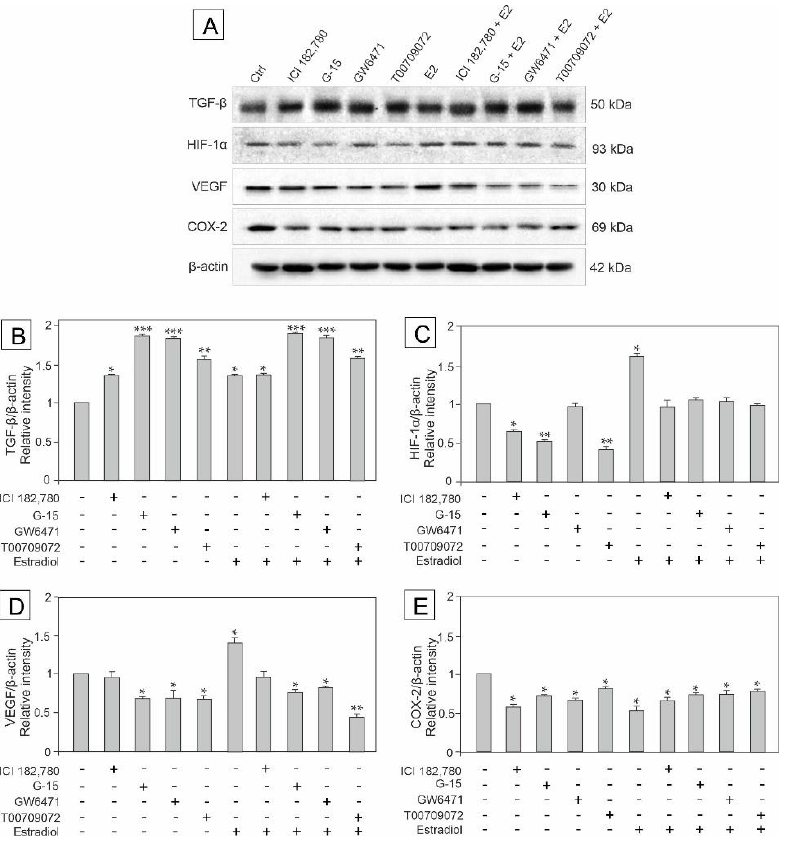
Figure 3. The effect of GPER agonist (ICI 182,780), GPER antagonist (G-15), PPAR α antagonist (GW6471), PPAR γ antagonist (T00709072), and estradiol (E2) on TGF- β , HIF-1 α , VEGF and COX-2 protein expression in mouse testis explants ( A – E ). Representative blots of Western analysis ( A ) and relative expression of the proteins ( B – E ). Explants were harvested after 24 h. Untreated explants served as a control. Untreated explants served as a control. Protein levels within control testis explants were given a value of 1. Displayed are the cropped blots and original blots are provided in Supplementary Materials Figure S1. The relative levels of the proteins were normalized to β -actin which served as the internal protein loading control. The histograms are the quantitative representation of data (mean ± SD) of three independent experiments, each in triplicate ( B – E ). A plus sign (+) indicates the presence of the compound in the culture medium, a minus sign ( – ) indicates no compound in the culture medium. Asterisks indicate significant differences from control explants.